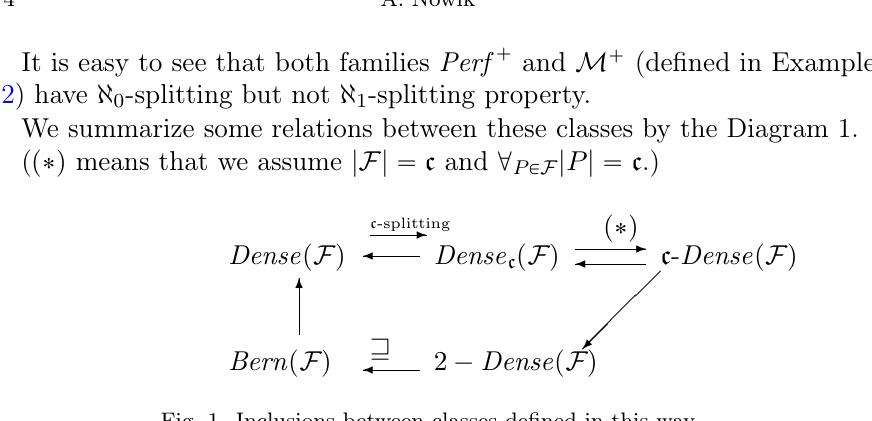
Fig. 1. Inclusions between classes defined in this